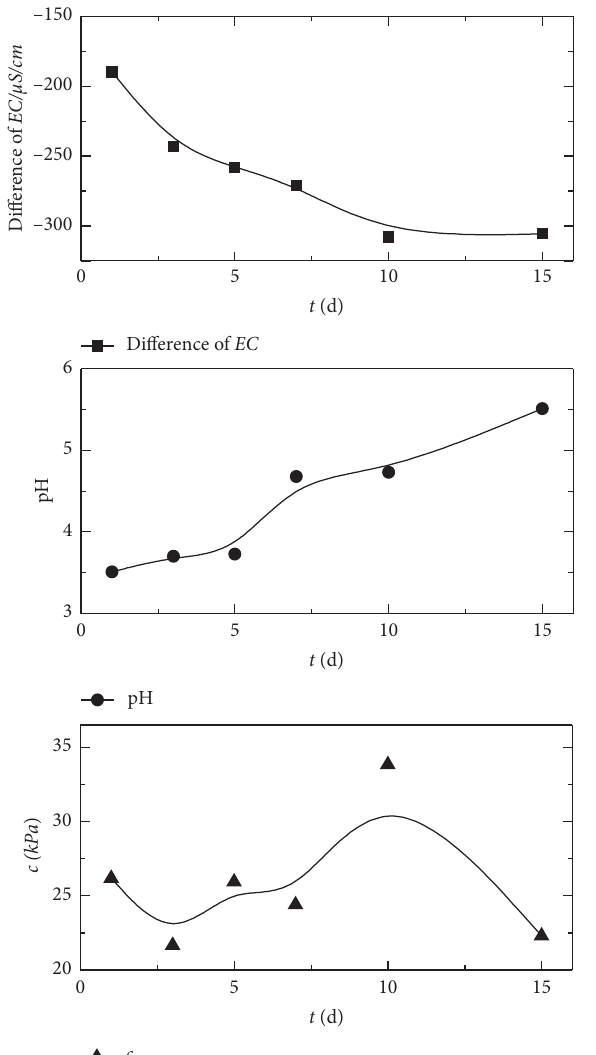
Figure 2: Characteristic verification of the soaking liquid pa- rameters and cohesive force (20 ° C, HNO 3 ).